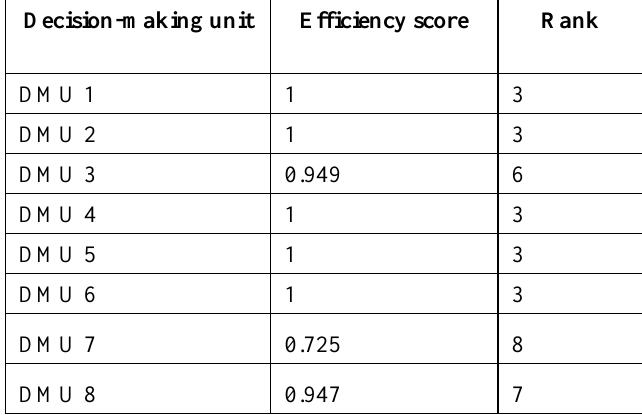
Table 3. Efficiency Scores of Real Estate Firms during the Pre-demonetization Period (developed by the author) Decision-making unit Efficiency score Rank